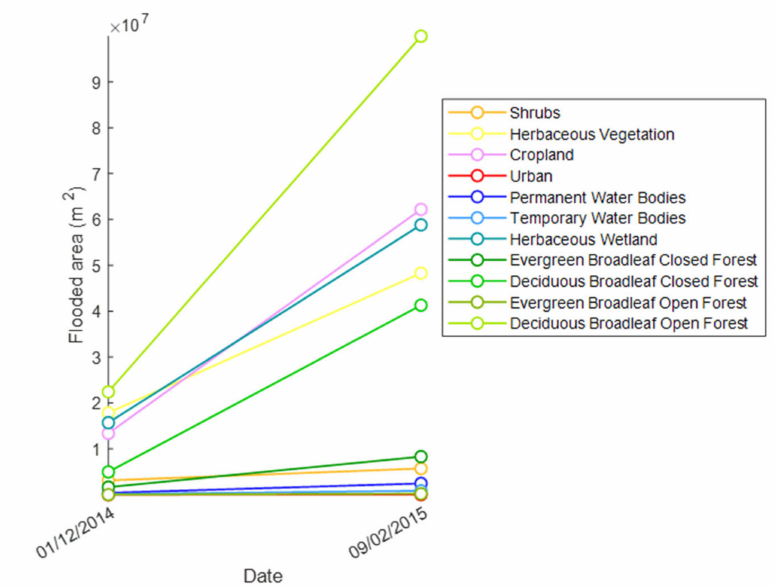
Figure 5. Estimation of the areas flooded for each CORINE land cover class, in the sequence of Sentinel-1 images. Colors in the legend follow the standard CORINE class